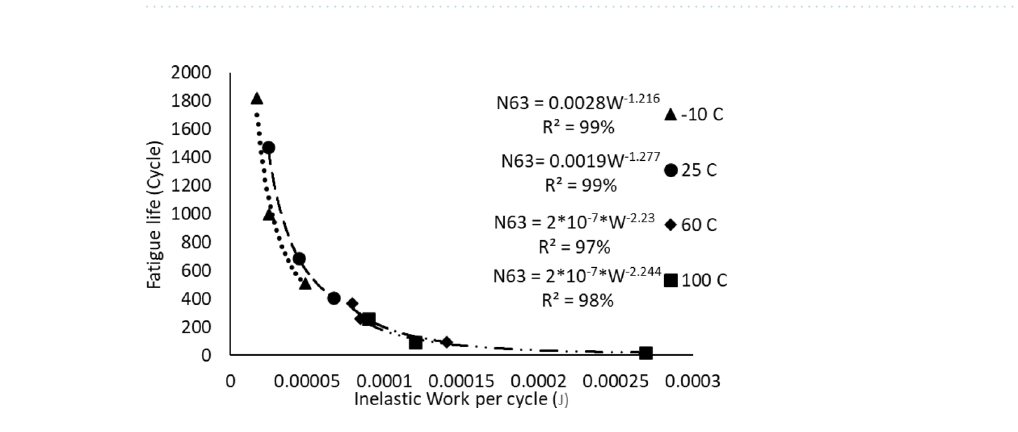
Figure 13. The impact of mutable testing temperature on the Morrow energy